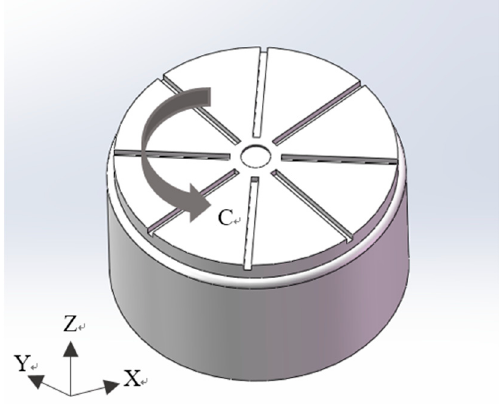
Figure 2. Schematic diagram of the rotary table coordinate system.